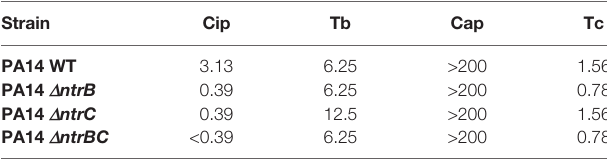
TABLE 1 | P. aeruginosa NtrBC mutants were more susceptible to cipro fl oxacin. Strain Cip Tb Cap Tc PA14 WT